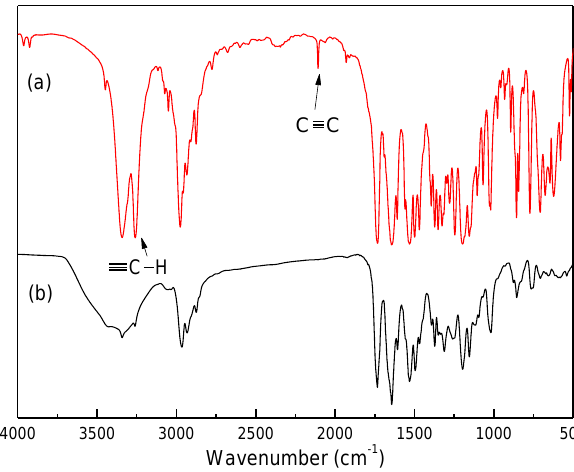
Figure 1. IR spectra of ( a ) monomer PAA-Val and ( b ) its polymer PPAA-Val.